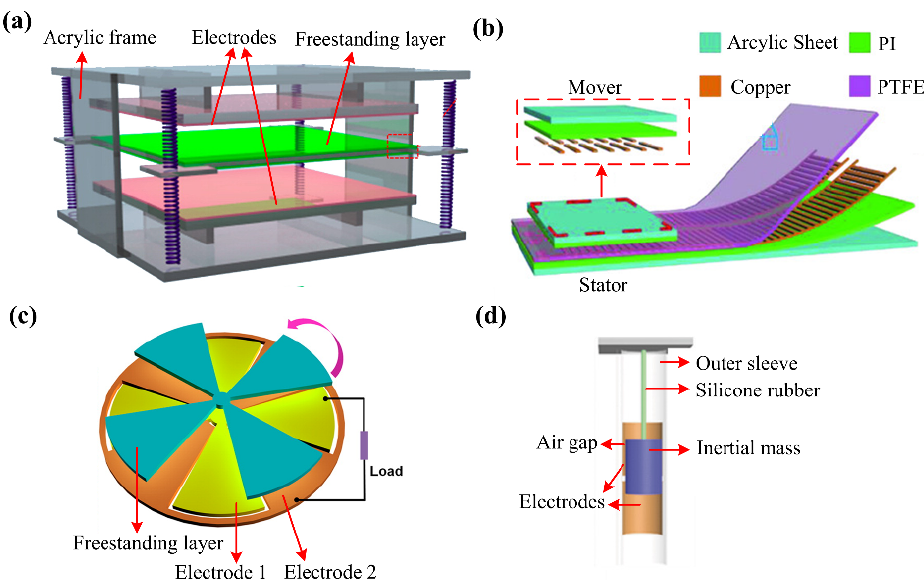
Figure 4. Structures of freestanding triboelectric-layer-based TENGs: ( a ) An FTENG with contact mode for vibration sensing (Reproduced with permission [23]. Copyright 2014 American Chemical Society); ( b ) A FTENG with sliding mode for translational motion sensing (Reproduced with per- mission [51]. Copyright 2018 WILEY-VCH Verlag GmbH & Co., KGaA, Weinheim, Germany); ( c ) A non-contact TENG with a disk-like structure (Reproduced with permission [52]. Copyright 2014 American Chemical Society); ( d ) A non-contact TENG with a tube-like structure (Reproduced with permission [53]. Copyright 2017 WILEY-VCH Verlag GmbH & Co., KGaA, Weinheim, Germany).